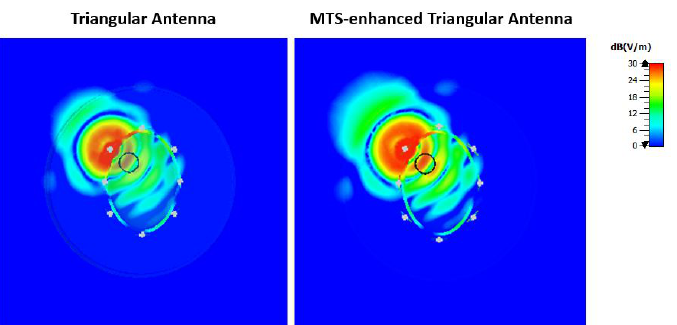
Figure 15. Real part of the E-field calculated at 0.9 GHz and plotted on a transverse section of the sim- ulated brain phantom including a blood-mimicking target. A higher field intensity in the target region is shown when the MTS is placed adjacent on the triangular antenna’s substrate (right plot). In partic- ular, the E-Field values calculated at the centre of the target are 23.14 dB (V/m) and 27.60 dB (V/m) for the triangular patch antenna and the MTS-enhanced triangular patch antenna, respectively.